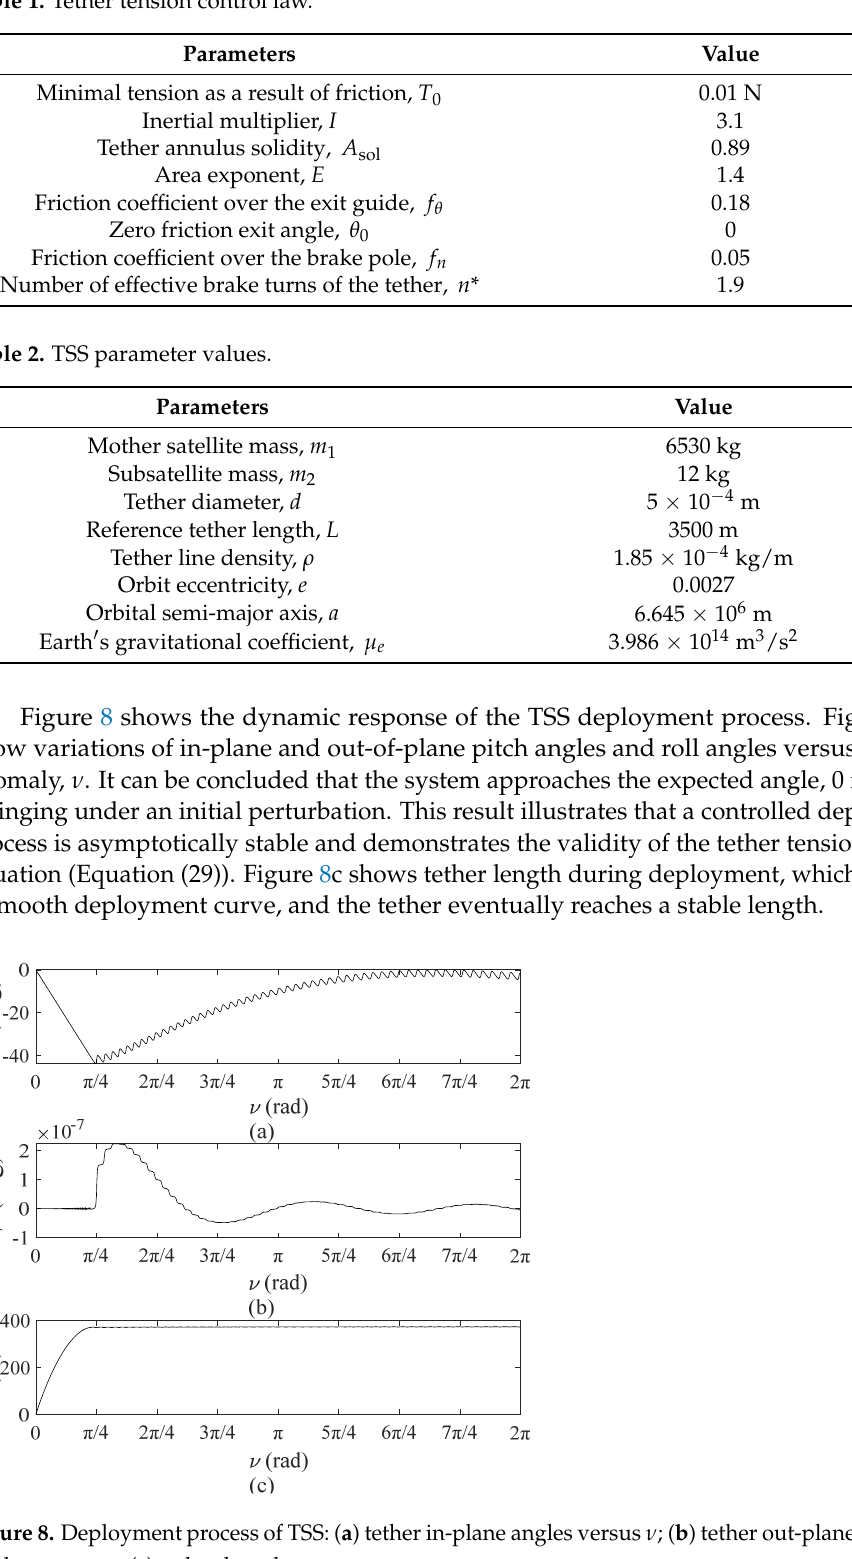
Table 1. Tether tension control law.